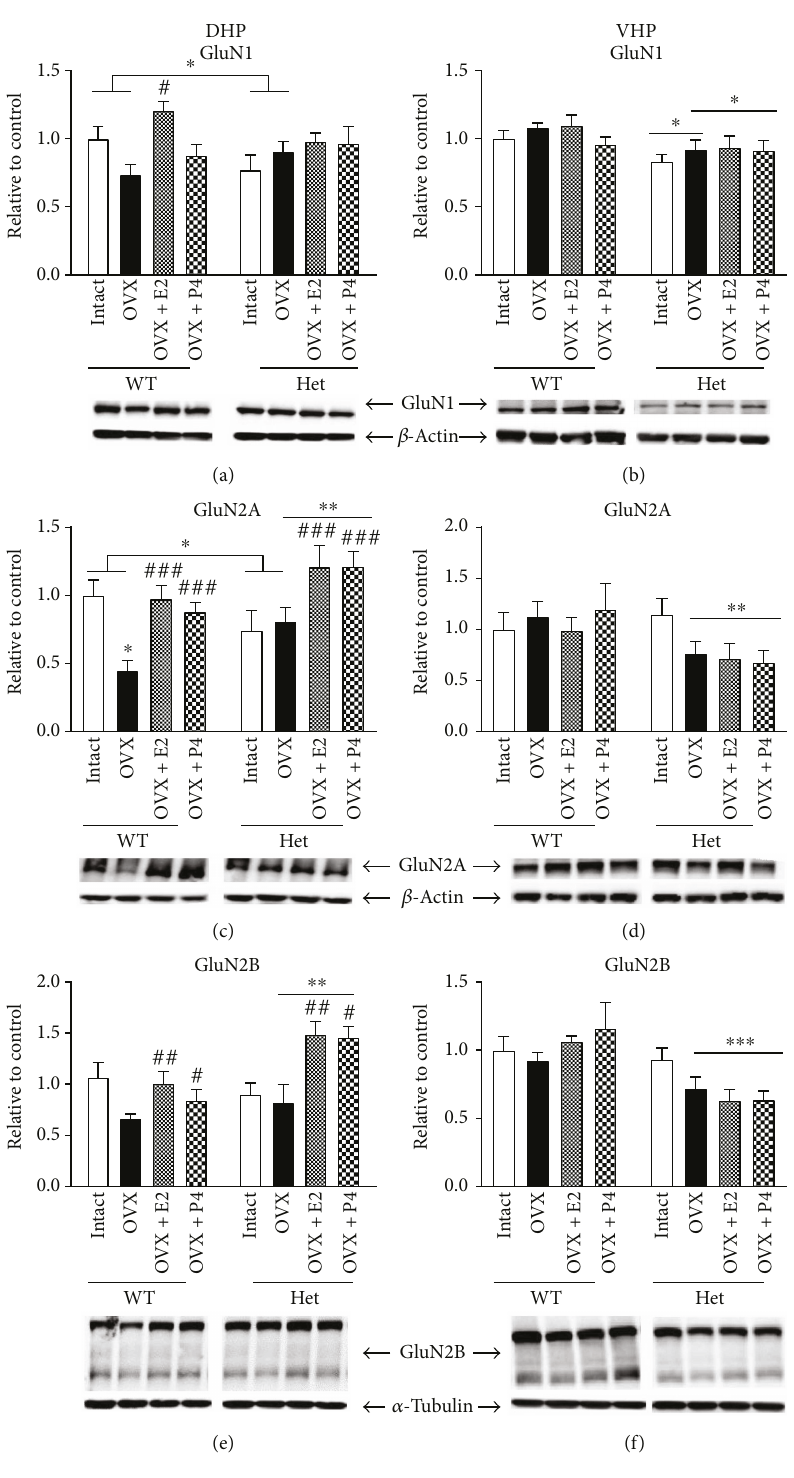
Figure 1: Protein expression of NMDA receptors in the dorsal (DHP) and ventral (VHP) hippocampus of female sham ovariectomized + placebo (intact), ovariectomized +placebo (OVX), OVX + estradiol (E2), and OVX+ progesterone- (P4-) treated mice. (a) GluN1 expression in the DHP, (b) GluN1 expression in the VHP, (c) GluN2A expression in the DHP, (d) GluN2A expression in the VHP, (e) GluN2B expression in the DHP, and (f) GluN2B expression in the VHP. N =5 – 7 per treatment group. ∗ p < 0 05 , ∗∗ p < 0 001 , and ∗∗∗ p < 0 0001 . Error bars represent the standard error of the mean (SEM). Two-way ANOVA was performed. Bars with connecting horizontal lines show signi fi cant interactions (OVX × genotype), fl at bars represent signi fi cant main e ff ects of the genotype, and ∗ above the OVX bar represents post hoc signi fi cant di ff erences between OVX and sham control, while # above hormone-treated bars represents signi fi cant di ff erences between hormone-treated OVX groups and OVX placebo. # p < 0 05 , ## p < 0 01 , and ### p < 0 005